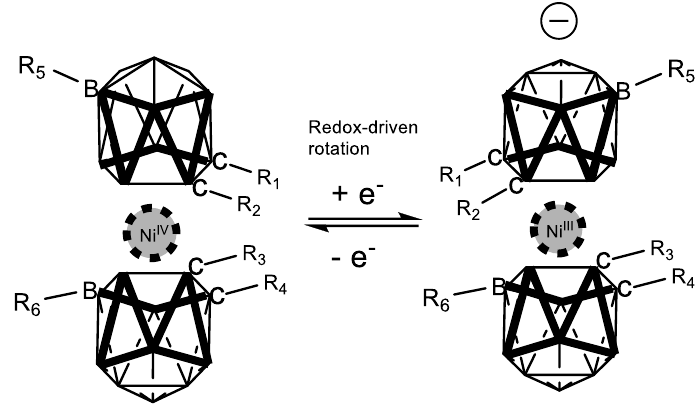
Figure 19. Computed properties of the rotational phenomenon of nickel-coordinated metallacarboranes, whose movement is redox- and NLO-dependent.